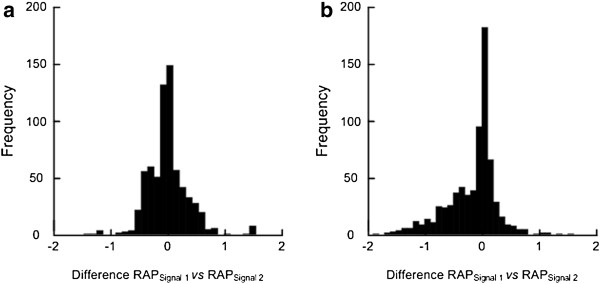
Histograms show frequency of differences in RAP between identical Signals 1 and 2 in patients 1 and 20. Histograms of differences in RAP between identical 4-min periods of Signal 1 and 2 are shown for PatID’s 1 [a; mean difference (+std) = 0.02±0.36, n = 685], and 20 [a; mean difference (+std) = −0.17±0.45; n = 718]. The histograms illustrate that despite minor mean difference in RAP between Signals 1 and 2 of all 4-min periods, the frequency of major negative and positive differences in RAP can be extensive.